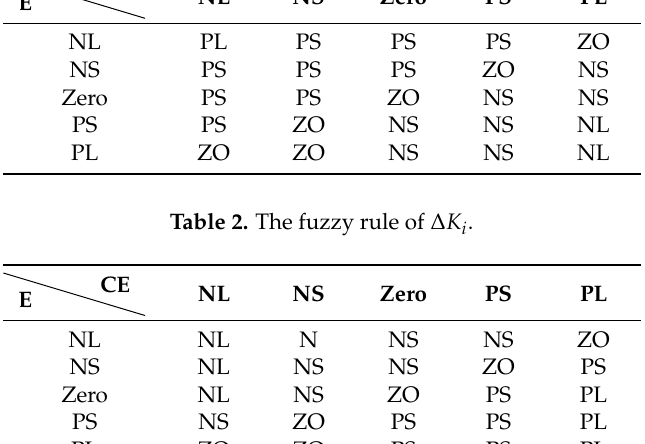
Table 1. The fuzzy rule of ∆ K p .